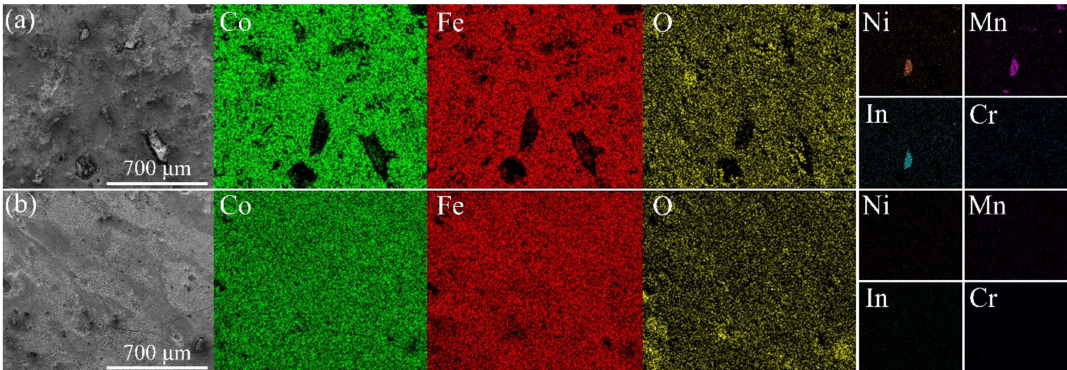
Figure 3. SEM micrograph and EDS mapping of ( a ) 1 h CoFe-coated alloy and ( b ) Cu-coated followed by 1 h CoFe-coated